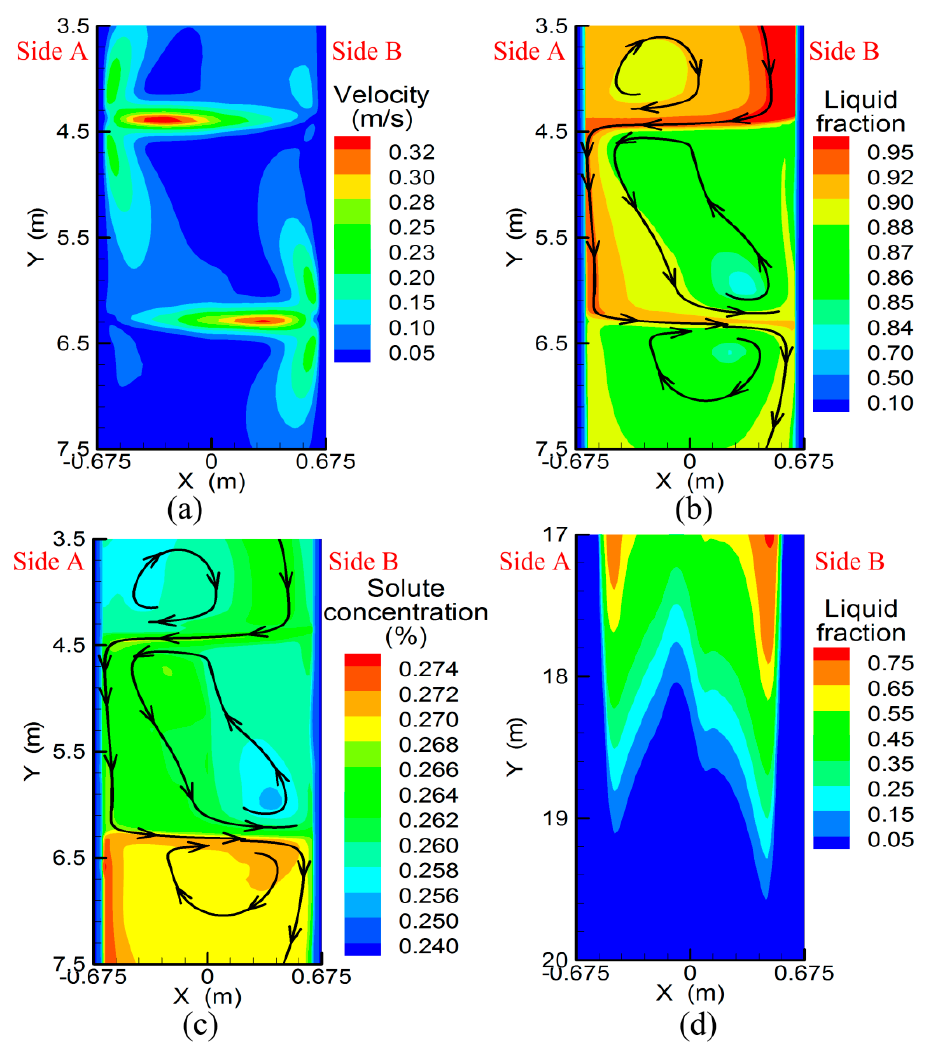
Figure 10. Fluid flow ( a ), liquid fraction ( b ), and solute concentration ( c ) in the stirring zone, liquid fraction distribution near the solidification end ( d ).